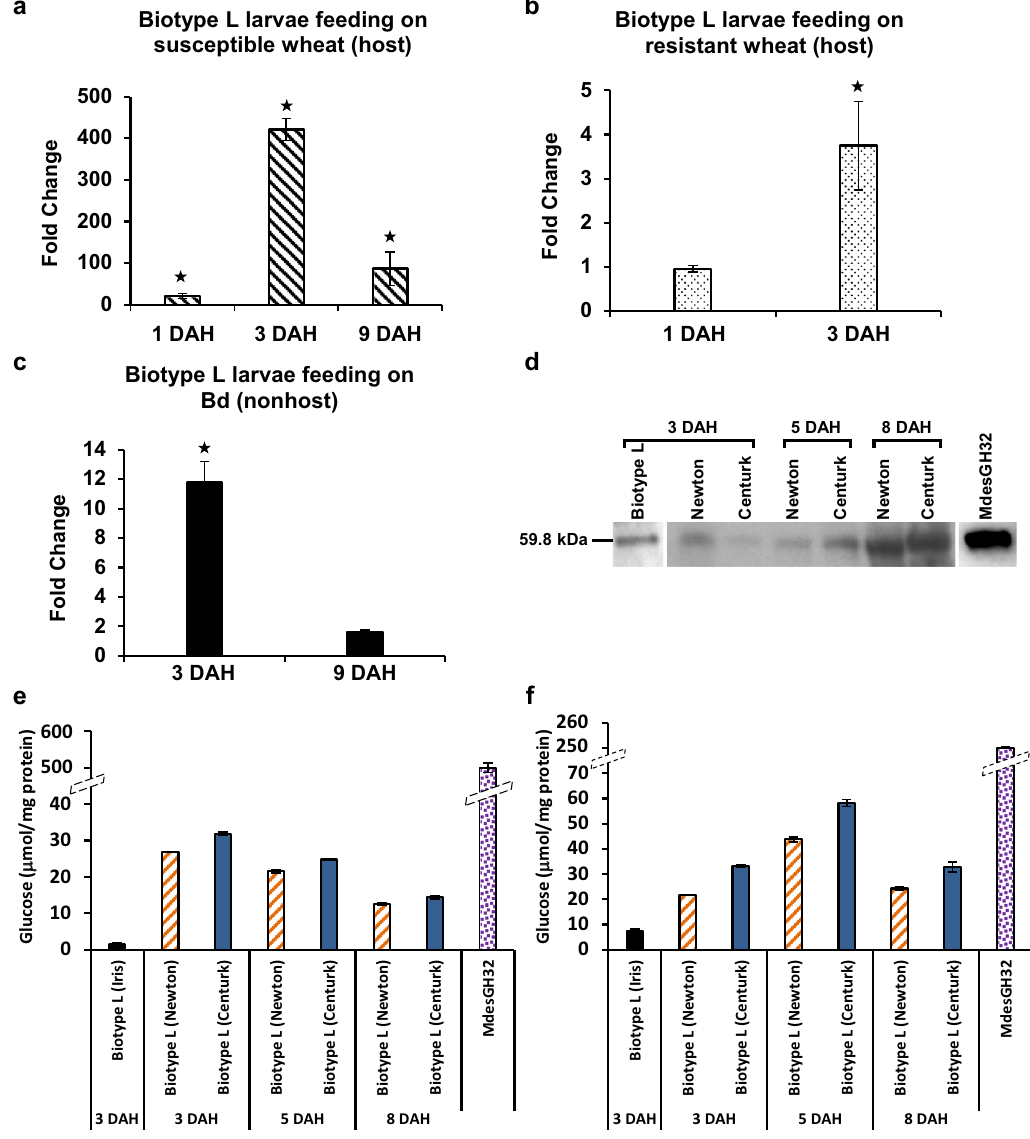
Figure 2. Temporal expression and activity of MdesGH32 . Transcript levels of MdesGH32 in ( a ) Virulent Biotype L Hessian fly larvae feeding on Newton (susceptible) host wheat. ( b ) Avirulent Biotype L Hessian fly larvae feeding on Iris (resistant) host wheat. ( c ) Biotype L Hessian fly larvae feeding on nonhost Brachypodium distachyon . Values are the fold change ± SE for transcript levels as compared to neonate larvae (collected on the day of egg hatch). Statistically significant ( p < 0.05) differences are indicated by “*”. Error bars represent data from three biological replicates ( n = 3; each with three technical replicates). ( d ) Immunodetection of MdesGH32 in susceptible wheat plants 3, 5 and 8 DAH, and virulent Biotype L larvae 3 DAH (first lane; run on a different gel). Purified recombinant MdesGH32 protein was used as a positive control (last lane; run on a different gel) and showed a single band of the expected size of 59.8 kDa. ( e ) Invertase activity of MdesGH32. ( f ) Inulinase activity of MdesGH32. Enzyme activities are quantified as μmol glucose/mg protein in Biotype L larvae from resistant (Iris), and susceptible (Newton and Centurk) wheat lines, and recombinant MdesGH32 and are represented as the mean ± SE from three biological replicates ( n = 3) for each